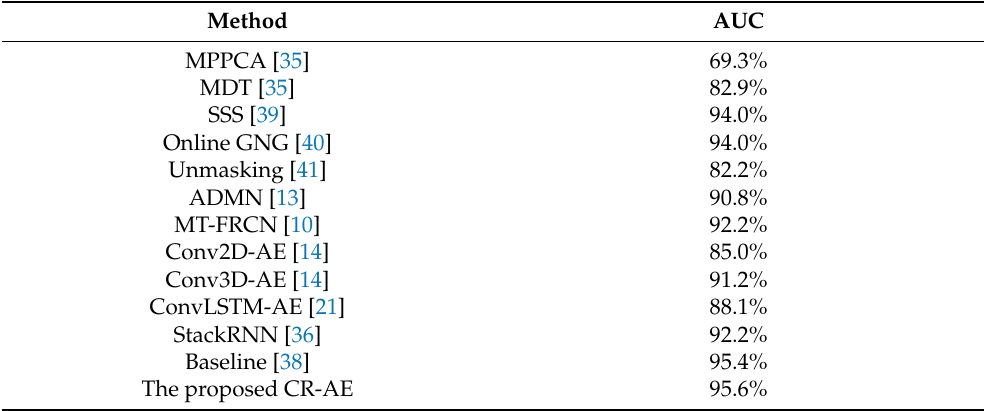
Table 2. Comparison with the state-of-the-art methods in terms of AUC% on the USCD Ped2